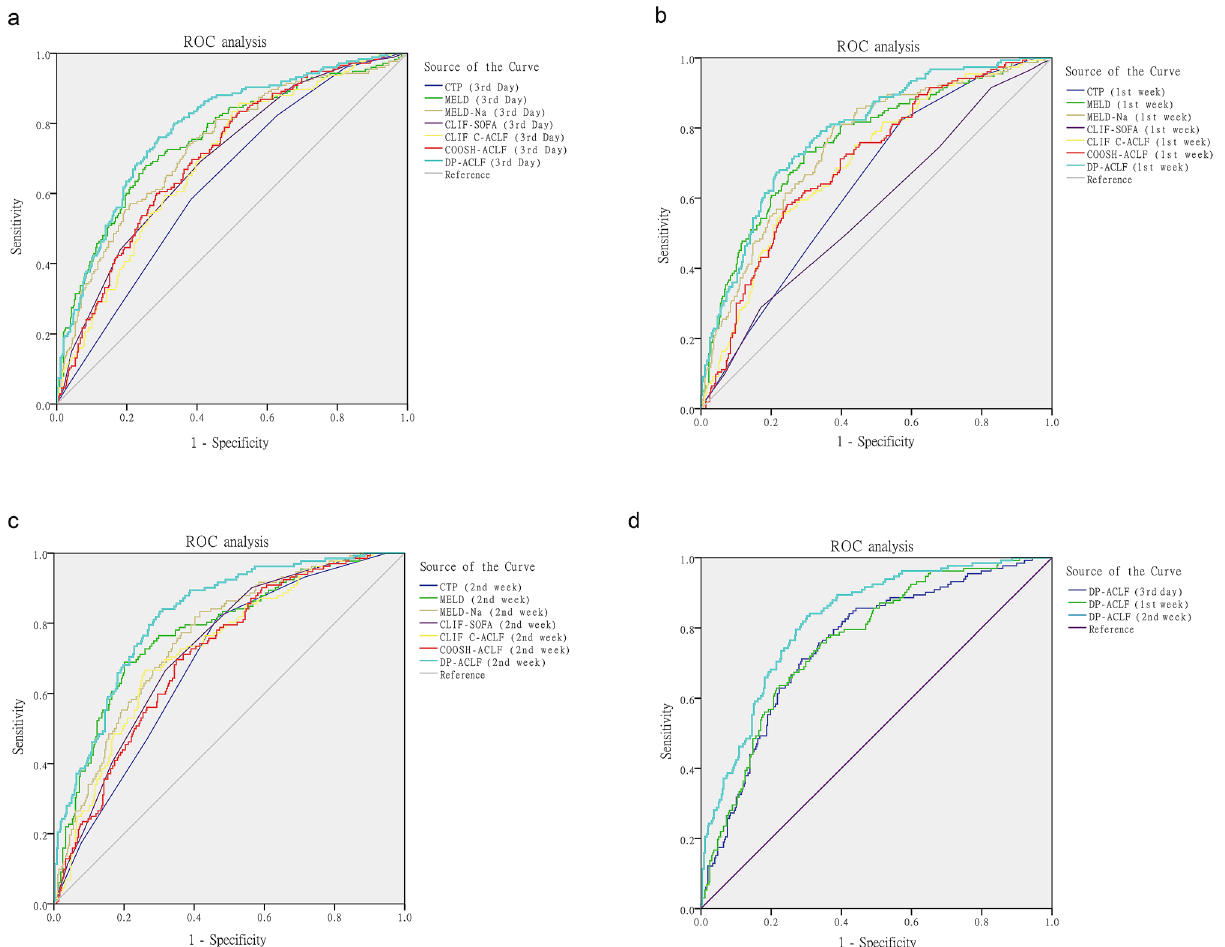
Figure 4. ( a–c ) DP-ACLF scores based on the patients of the training set at the third day, first week, and second week after admission, respectively, and comparison of ROC curves with other prognostic scores at the same time point. ( d ) ROC curve comparisons of DP-ACLF scores at different time points.